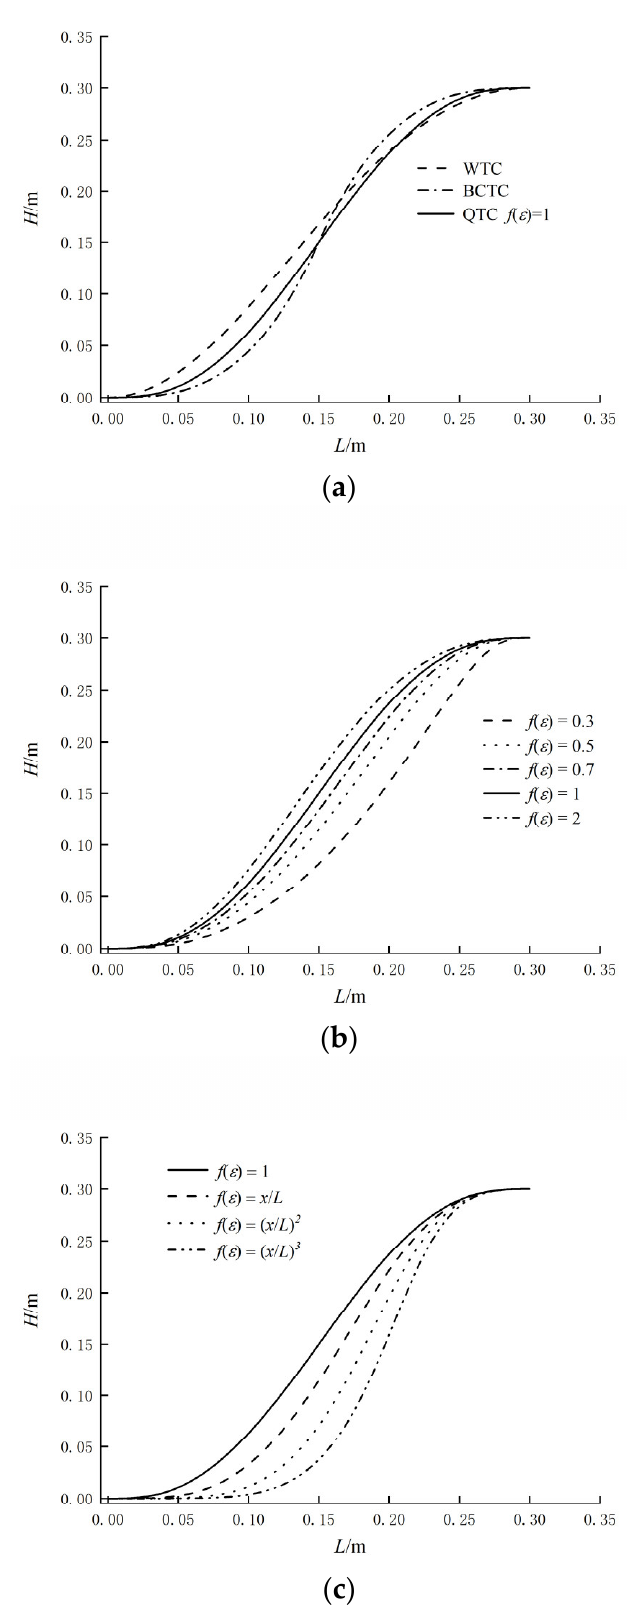
Figure 4. Terrain transition curve with different parameters. ( a ) Witoszynski transition curve, bi- cubic transition curve, and quantic transition curve. ( b ) Quantic transition curve for constant f ( ε ). ( c ) Quantic transition curve for variable f ( ε ).